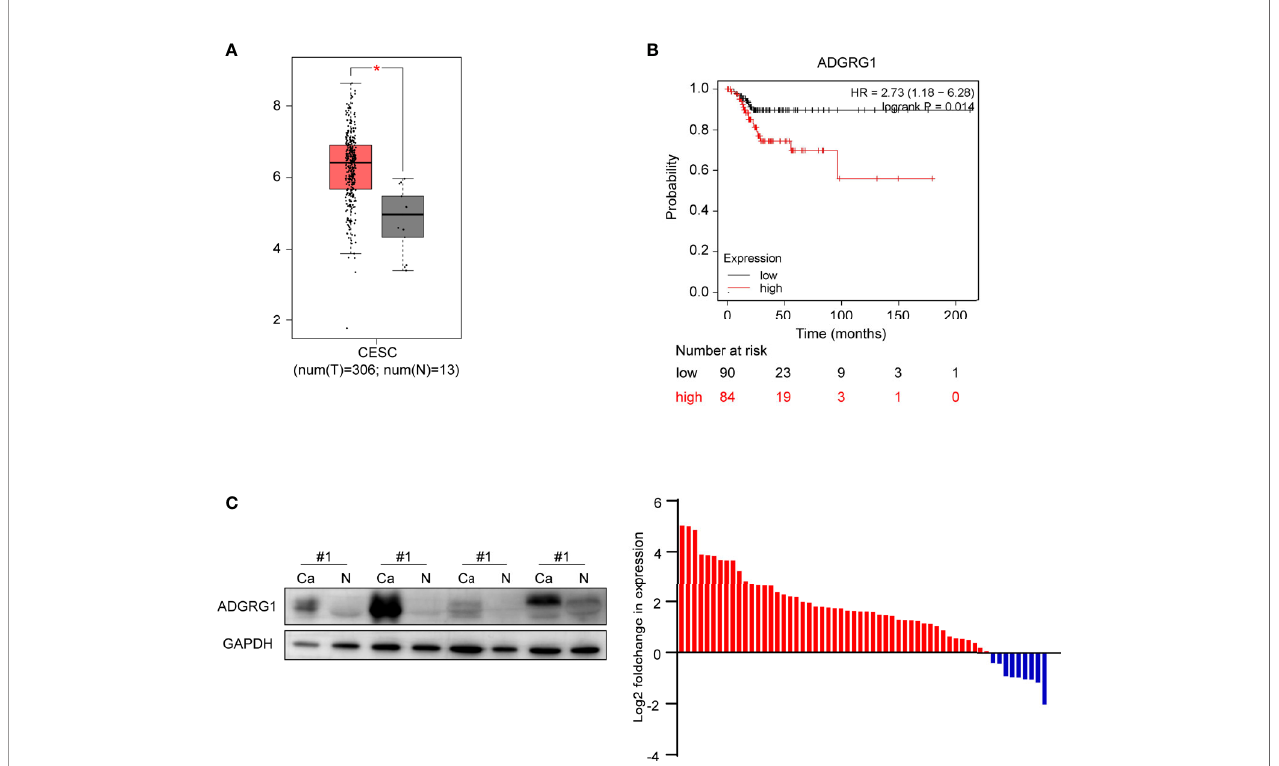
FIGURE 3 | ADGRG1 expression in tissue and its correlation with survival. (A) ADGRG1 is overexpressed in cervical carcinoma tissues in the dataset from GEPIA (*p < 0.01). (B) Kaplan-Meier survival curves demonstrate that high expression of ADGRG1 was negatively correlated to relapse-free survival (RFS). (C) ADGRG1 protein expression in 58 pairs of cervical cancer tissues and adjacent normal cervix were detected by western blotting. Using GAPDH as an internal reference, ADGRG1 relative expression level was presented as log2(foldchange Ca/N). Red color represents overexpression in cancer tissue, and blue represents underexpression in cancer